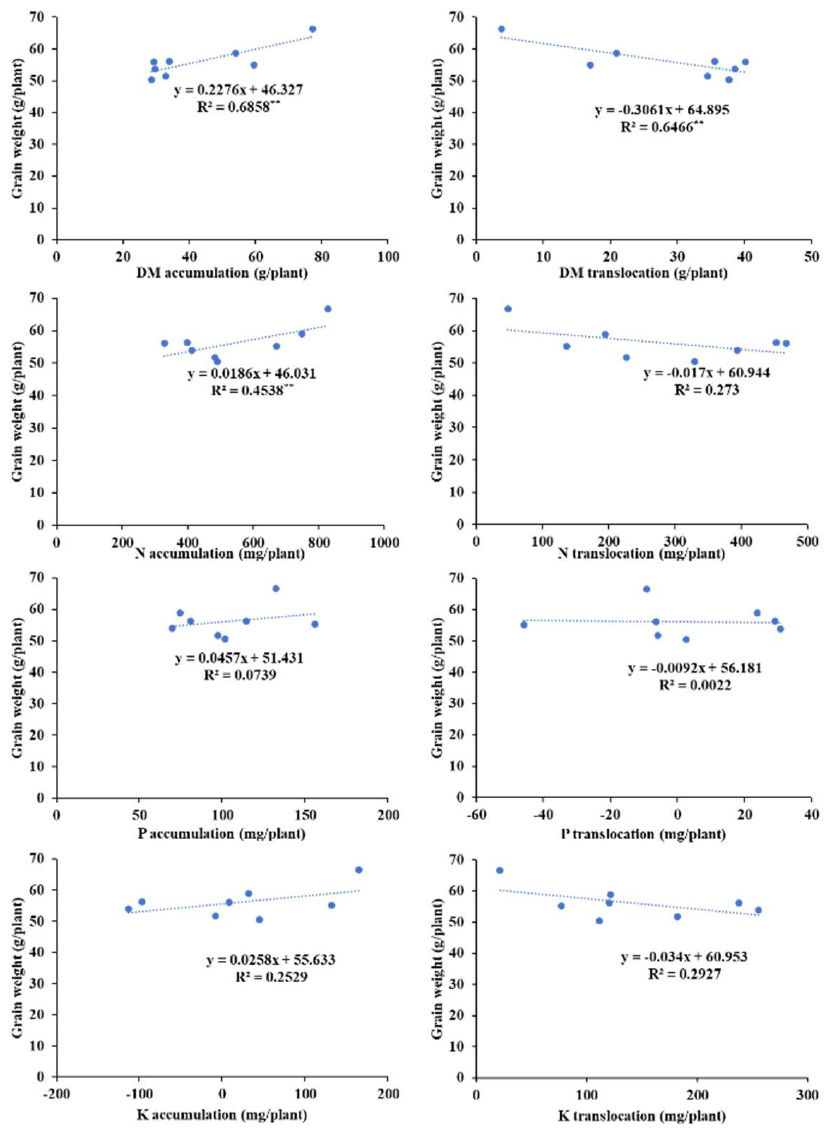
Figure 6. Correlation of grain weight and post–silking accumulation and pre–silking translocation amount biomass and nutrient. **, p < 0.01.